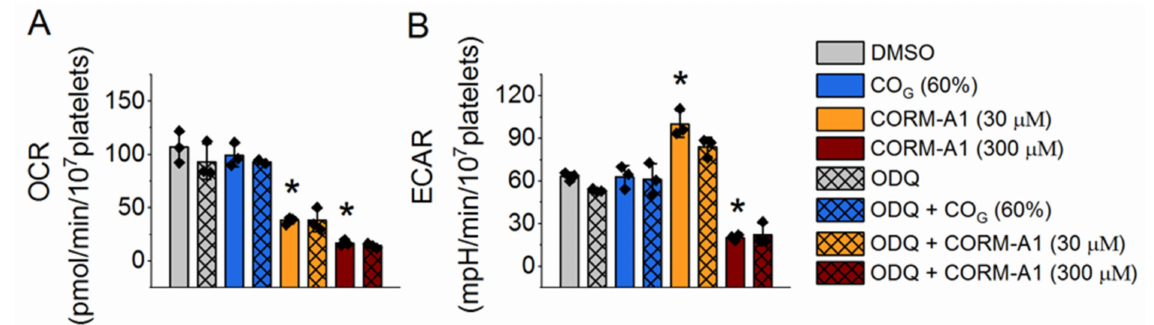
Figure 2. Distinct effects of CORM-A1 and CO gas on platelet energy metabolism. ( A ) Oxygen consumption rate (OCR) and ( B ) extracellular acidification rate (ECAR) were analyzed by Seahorse XF96 Analyser. Platelets were treated with DMSO or ODQ or CO G (60%) or CORM-A1 (30 or 300 µ M) just before the start of the Seahorse assay; the readouts were taken 30 min after treatment. Data represent means +/-SD from at least three independent experiments. * p < 0.05 as compared with the corresponding control.